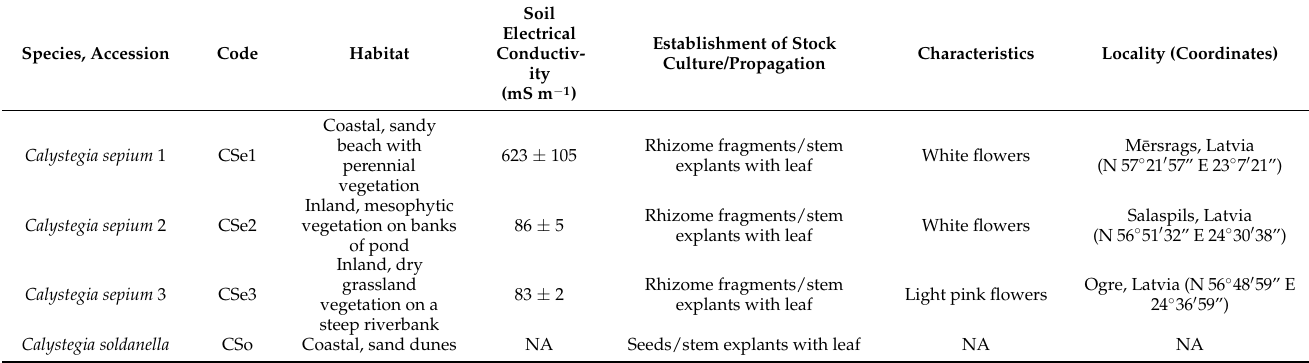
Table 1. Plant material used in the present study for the establishment of a laboratory culture of Calystegia sepium and Calystegia soldanella